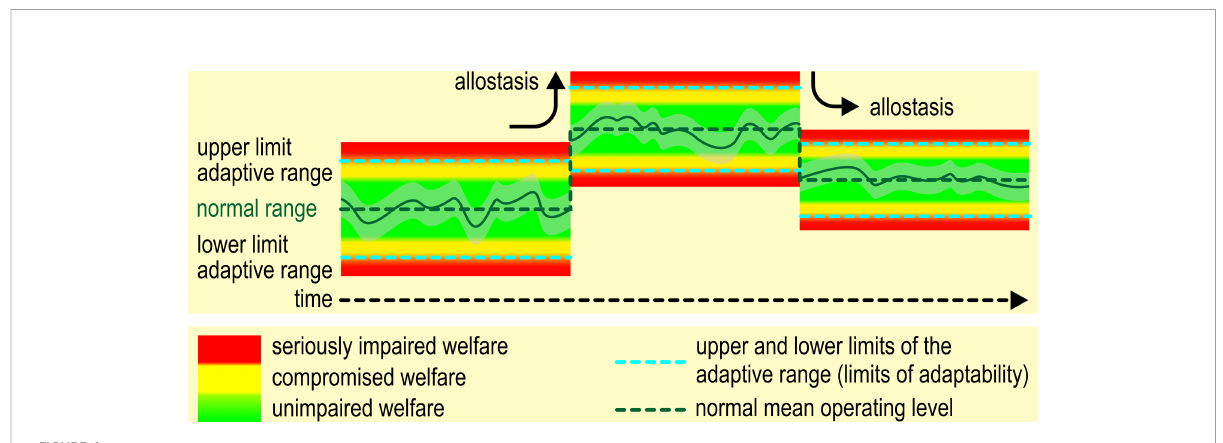
FIGURE 4 Homeostasis and allostasis in the context of animal welfare. Note that, if the animal reaches its limits of adaptability (blue dashed lines), its welfare becomes compromised (see also Figure 1). Values within the normal range will not impair the animal ’ s welfare, although values approaching the limits of adaptability may compromise